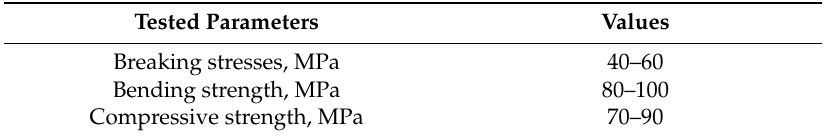
Table 2. Strength parameters of the epoxy resin Epidian 53 with the addition of the Z-1 curing